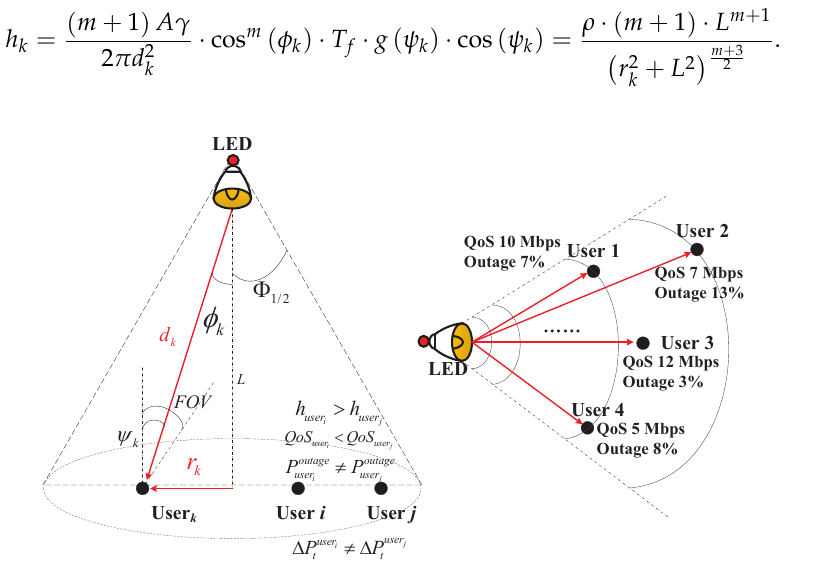
Figure 1. Visible light communication (VLC) user scenario. The labels FOV, LED, and QoS are field of vision, light emitting diode, and quality of service,